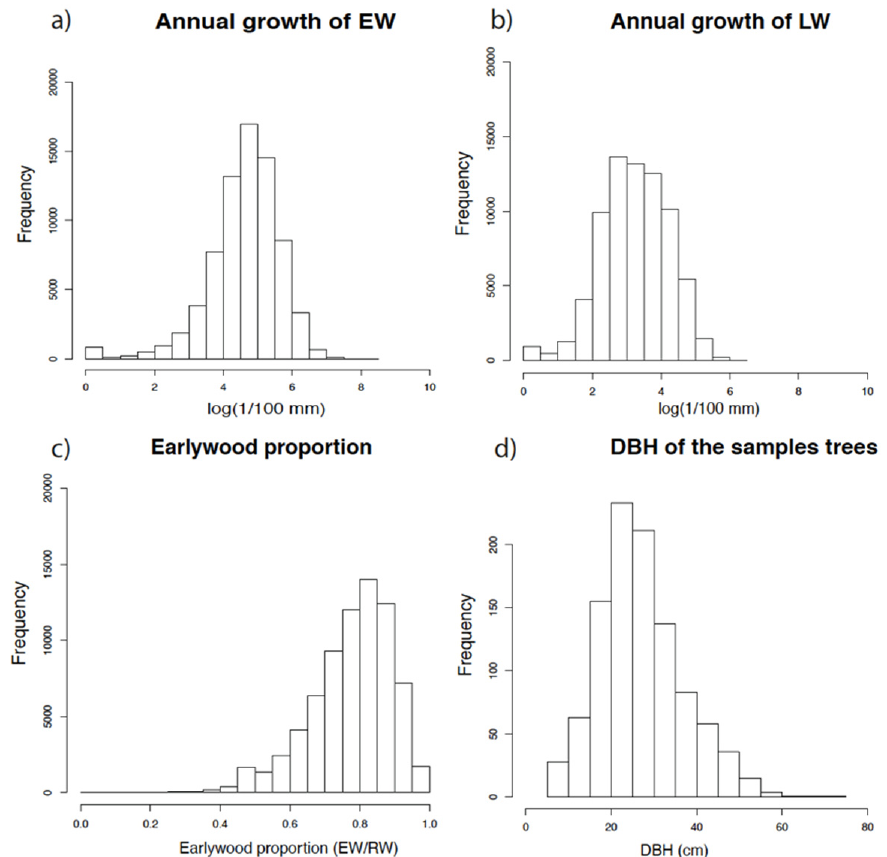
Figure 4. ( a ) Annual growth of EW. ( b ) Annual growth of LW ( a , b ) There were 73,238 annual growth values from 139,634 growth rings—2 per tree overall. ( c ) Earlywood proportion (EW/RW). ( d ) DBH of the sampled trees (1026 trees).